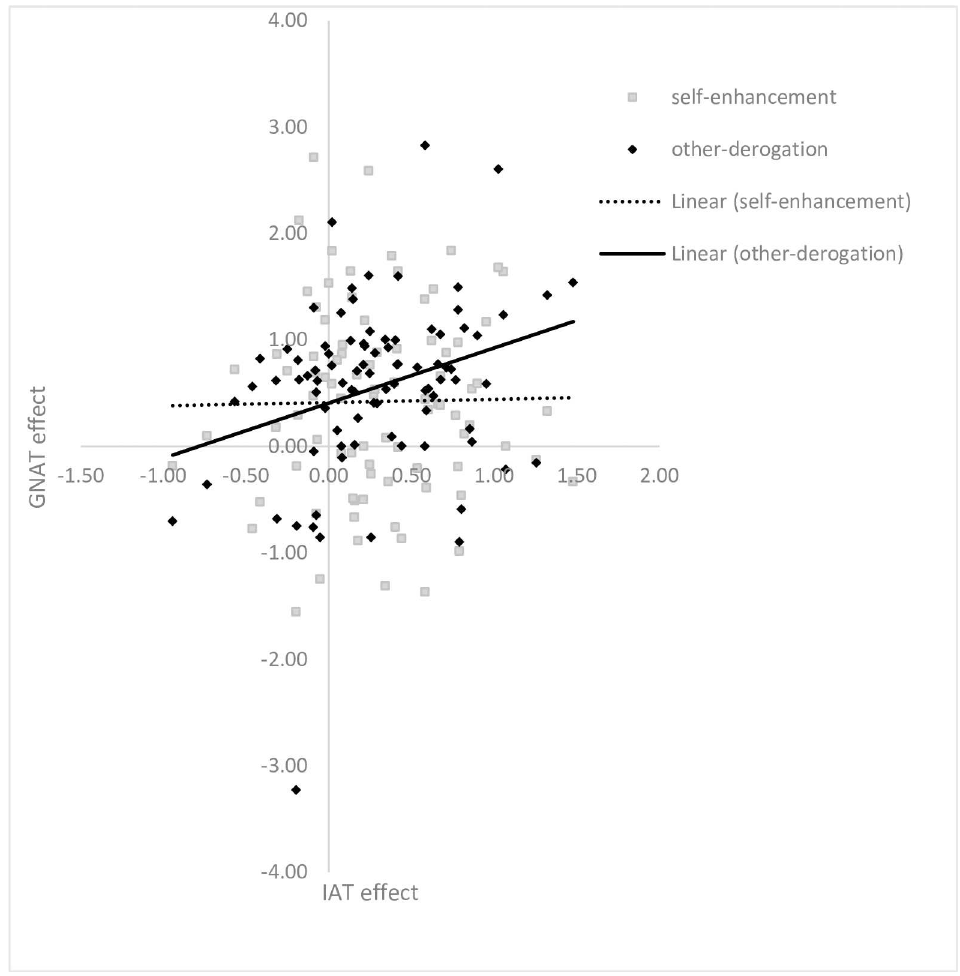
Fig 1. The Relationship between IAT and GNAT. The IAT effect = the D score in IAT; the GNAT effect for self-enhancement = d ’ self-possessions & positive − d ’ self-possessions & negative in the GNAT; the GNAT effect for other- derogation = d ’ other-possessions & negative − d ’ other-possessions & positive in the GNAT. Fitted lines were derived from linear